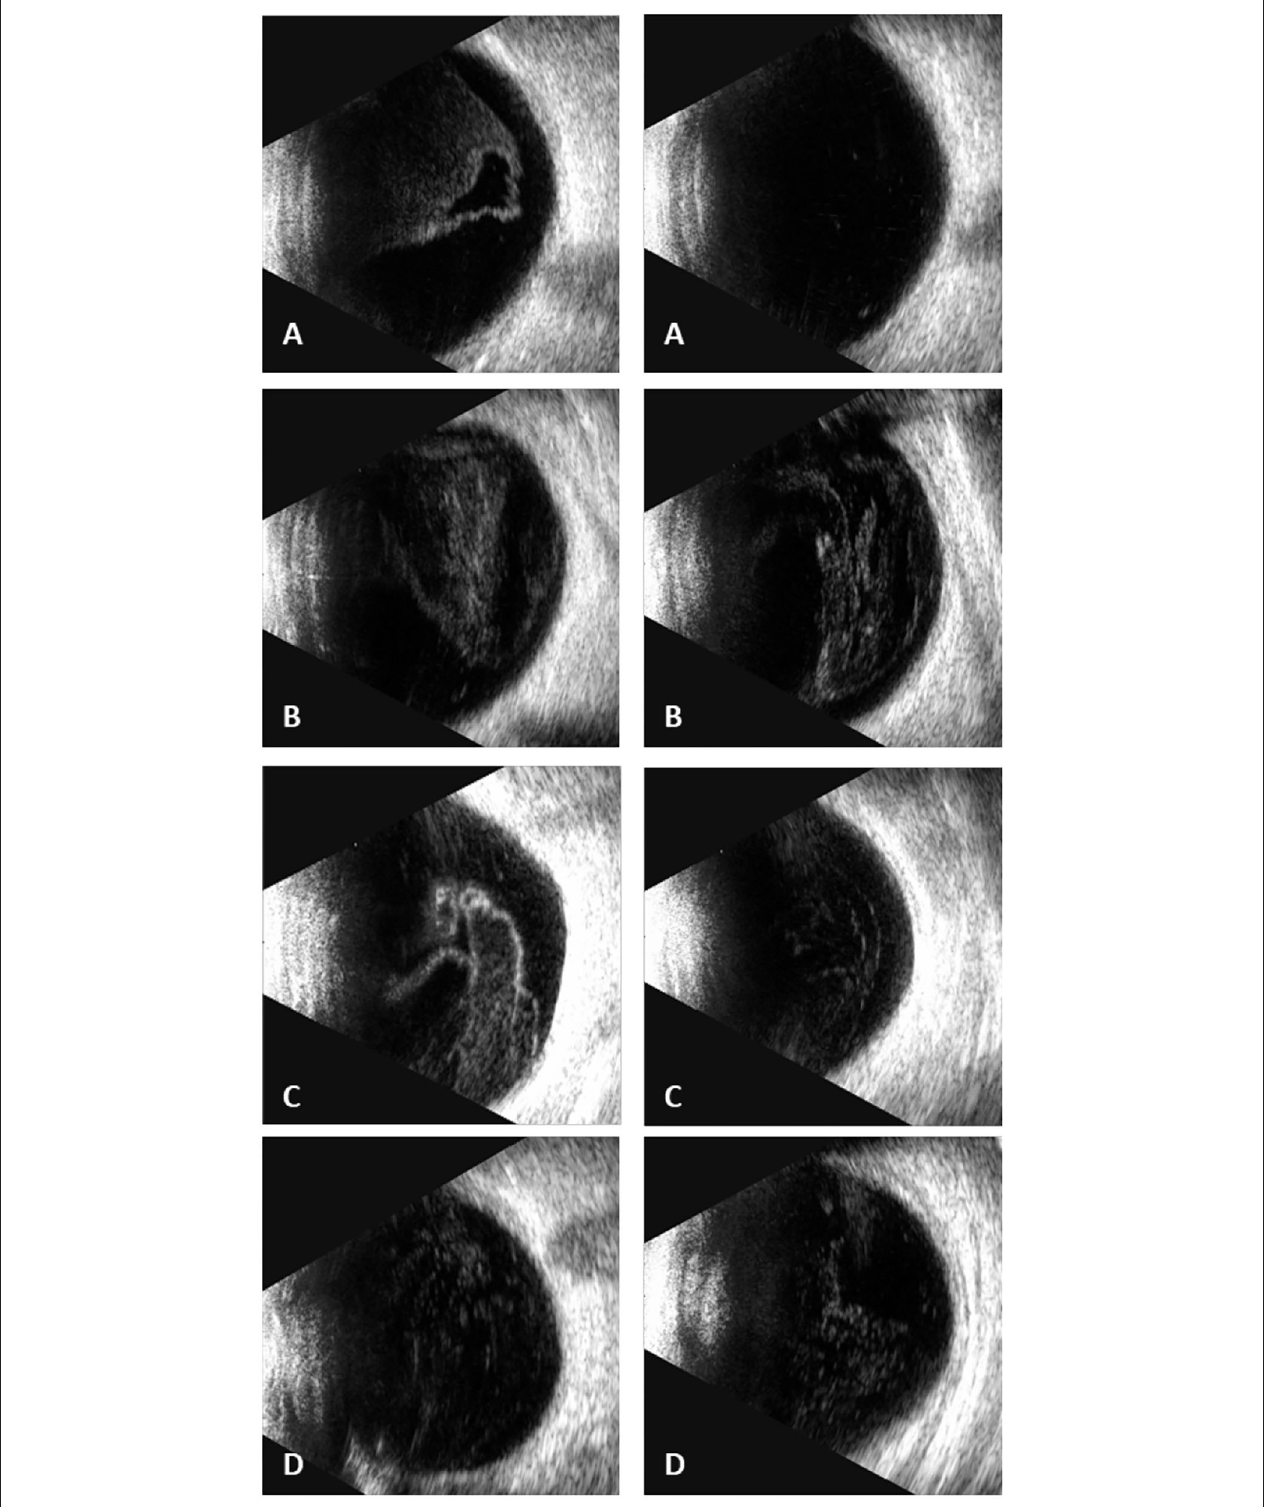
FIGURE 3 | Ultrasound B scans demonstrated severe vitritis in all four patients [ (A) patient one, (B) patient two, (C) patient three, (D) patient four] (Left: the right eye; right: the left eye) [ (D) shows only the left eye for the atrophy of the right eye].